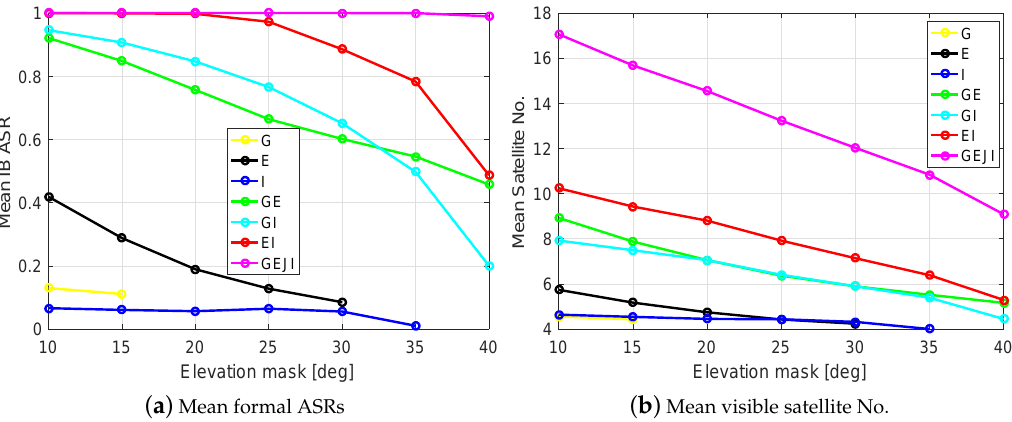
Figure 7. Mean formal IB ASRs ( a ) and the corresponding mean visible satellite numbers ( b ) for baseline CUAA-CUCC on DOY 224, 2018. The data sampling rate is 1 Hz.